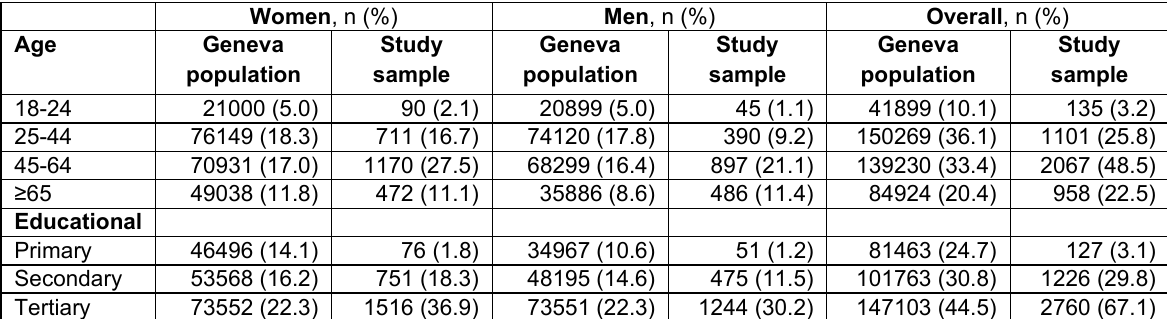
Supplementary table 3 . Characteristics of study participants* and of the general adult population of Geneva,